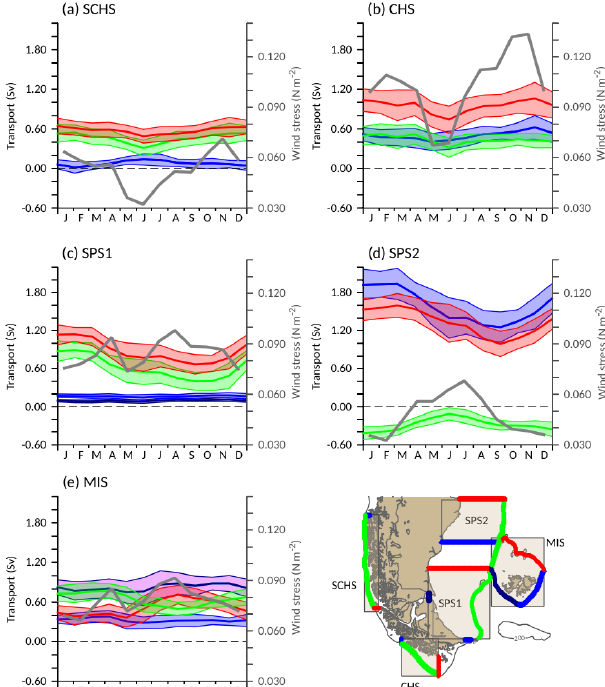
Figure 9. Mean seasonal variability of the transport across the key areas: SCHS (a) , CHS (b) , SPS1 (c) , SPS2 (d) , and MIS (e) . The transport is defined as positive in the direction of the main flux (polewards in the Pacific, equatorwards in the Atlantic) and towards the shelf. The shaded areas represent the standard deviation from the 27 years of simulation. Bottom right shows a reference map of the sections of each key area where the seasonal transport has been calculated and their associated colors. The grey line in each panel is the zonal wind stress in the area, calculated in the shaded regions indicated in the reference